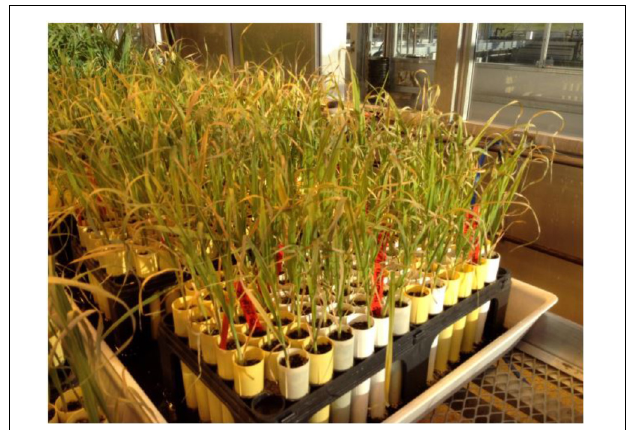
FIGURE 1 | The cone-tainer planting